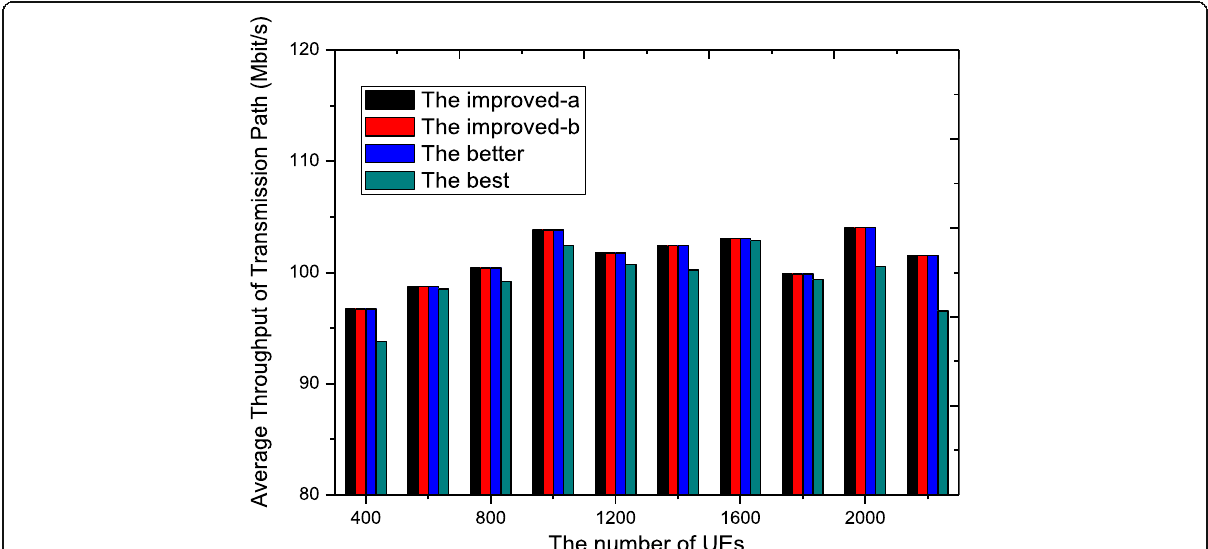
Fig. 9 Throughput performance comparison: variation trend of throughput of TOM-PAOD with the number of UEs in the given region, in which the different game decision algorithms are adopted respectively